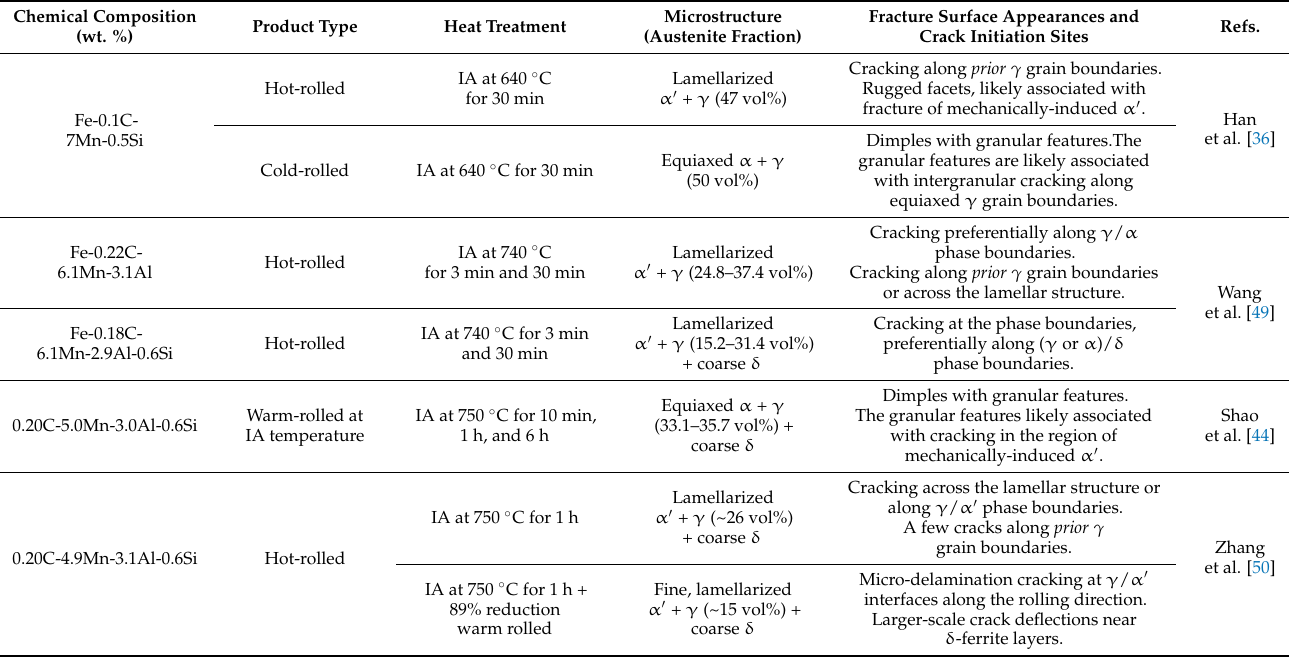
Table 3. Fracture surface appearance and crack initiation sites of H–embrittled medium–Mn steels ( α , α –ferrite; α (cid:48) , α (cid:48) –martensite; γ , austenite; and δ , δ